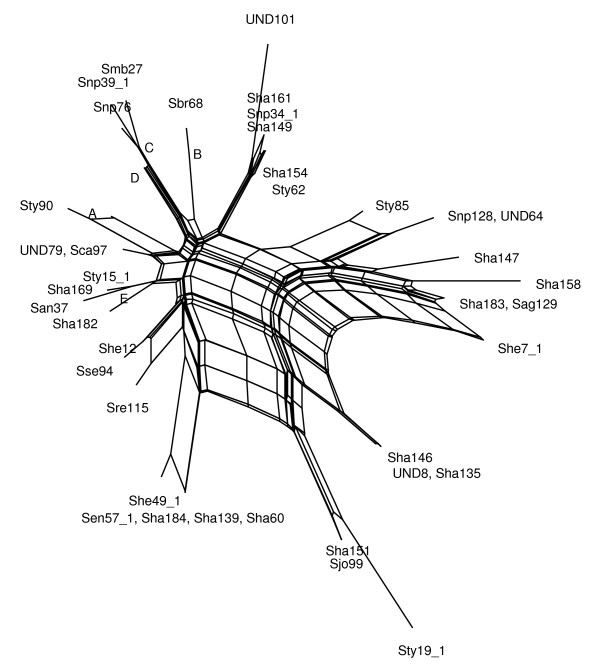
The MC-Net network for the Salmonella data set. Group A includes the isolates Sty54, Sty54*, Sty2, She9, Sty87, Snp40*, Sty13, Snp41*, Sen5, Sha160, Sha141, Sty20*, Sha58, Sse18, Sha71, Sty31. Group B includes the isolates Sty61, Sha148, Smb-17, Sag75, Sha124. Group C includes the isolates UND3, Sha150, Sha173, Sen23*, Sha153, Sha140, San96, Sen30*, Sen24*, Sha138, Sha176, Sha130, Sha164, Sha157, Sen29*, Sca93, Sha122, Sht20, Sha186. Group D includes the isolates She3, Sha50, Sse95, Sha56, Sen24, Sen34, Sha177, Sty13*, Swo44, Sty86, Ste41, Sha77, UND80. Group E includes the isolates Ssc40, Sse28, Sty89, Sty15*, Ske69, UND110, Sha49, Sen4, Sha48, Sha165, Sty92, Snp33*, Sty52, UND109, Sha131, Sha102, Sty6, Sha175.